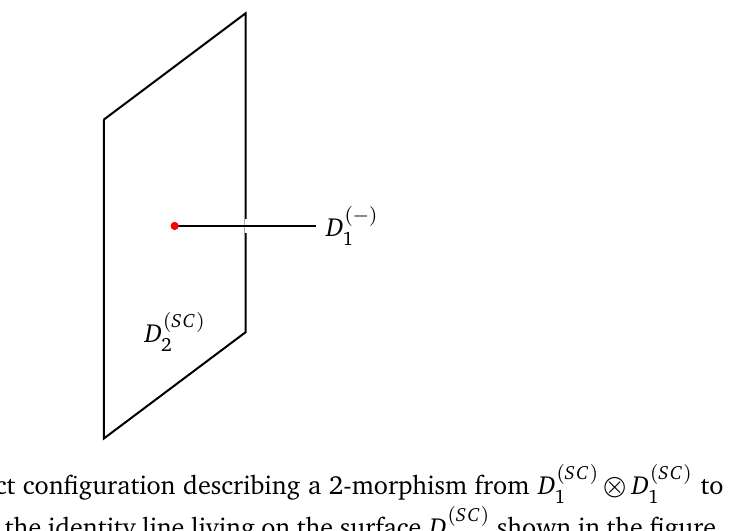
Figure 26: The defect configuration describing a 2-morphism from D p SC q D p´q , where D p SC q is the identity line living on the surface D p SC q 1 1